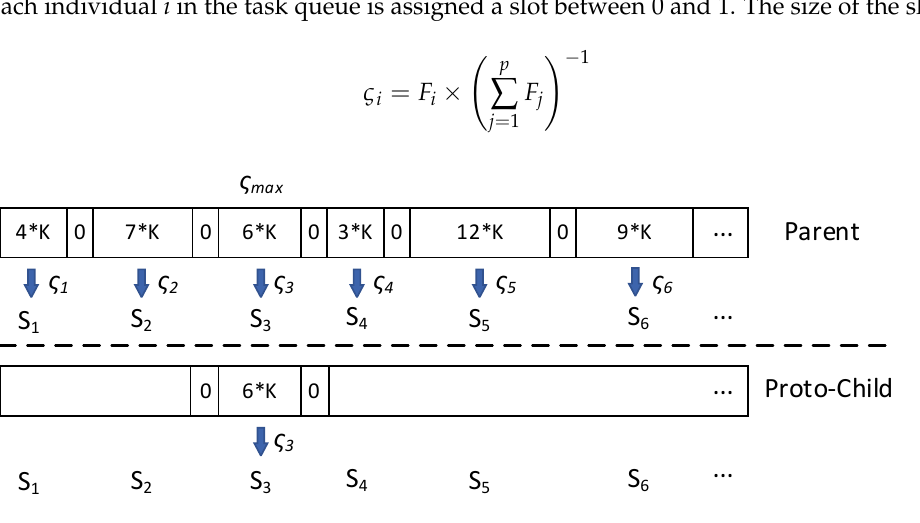
Figure 5. Selection of tasks, where perform a “select” operation on tasks in the queue.